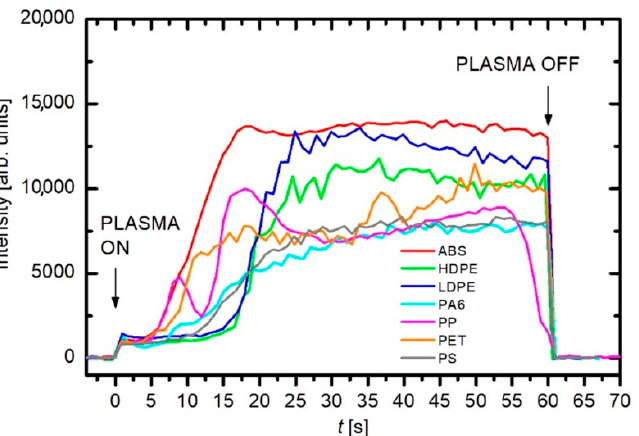
Figure 5. Variation of the OES intensity of C 2 species formed during burning of different polymer materials in nitrogen plasma.